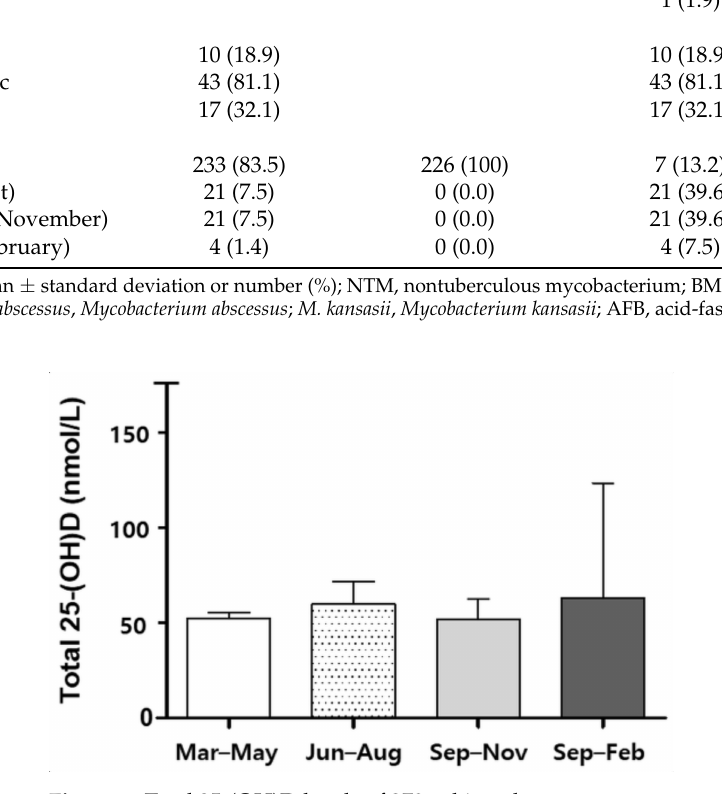
Figure 2. Total 25-(OH)D levels of 279 subjects between